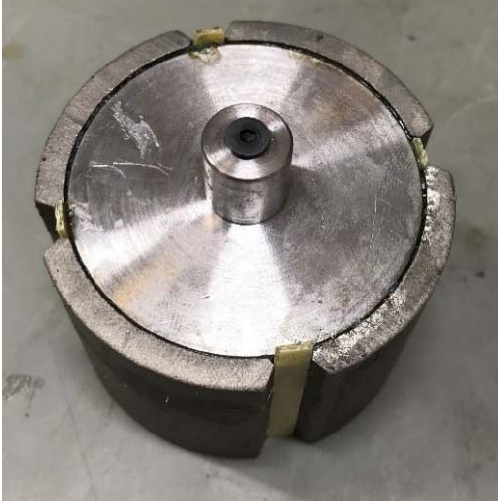
Figure 14. Rotor and permanent magnets of the motor.